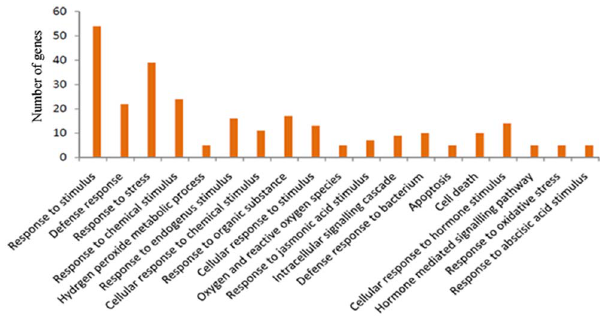
Figure 6. Histogram showing the significantly enriched Gene Ontology terms associated with up regulated genes in C. amada . The y-axis indicates the number of genes in a category. doi:10.1371/journal.pone.0099731.g006 PLOS ONE |